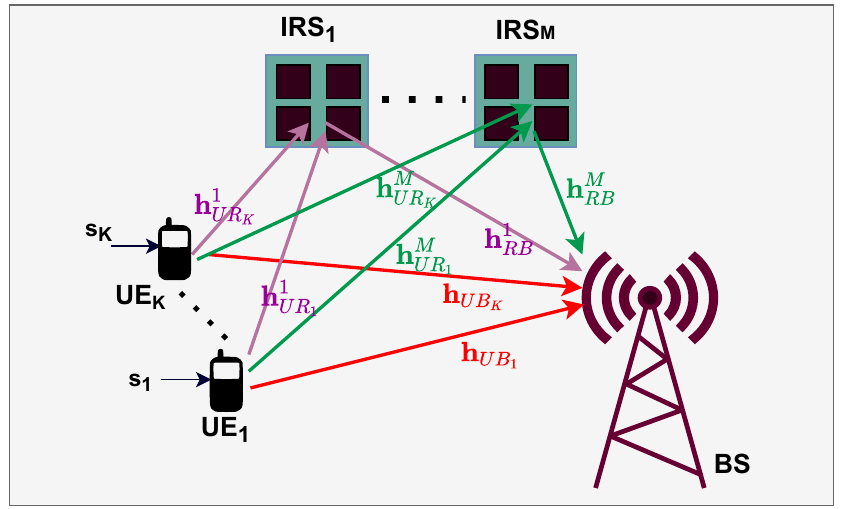
Figure 9. IRS-assisted Uplink Communication System: Multi-IRS and Multi-User.